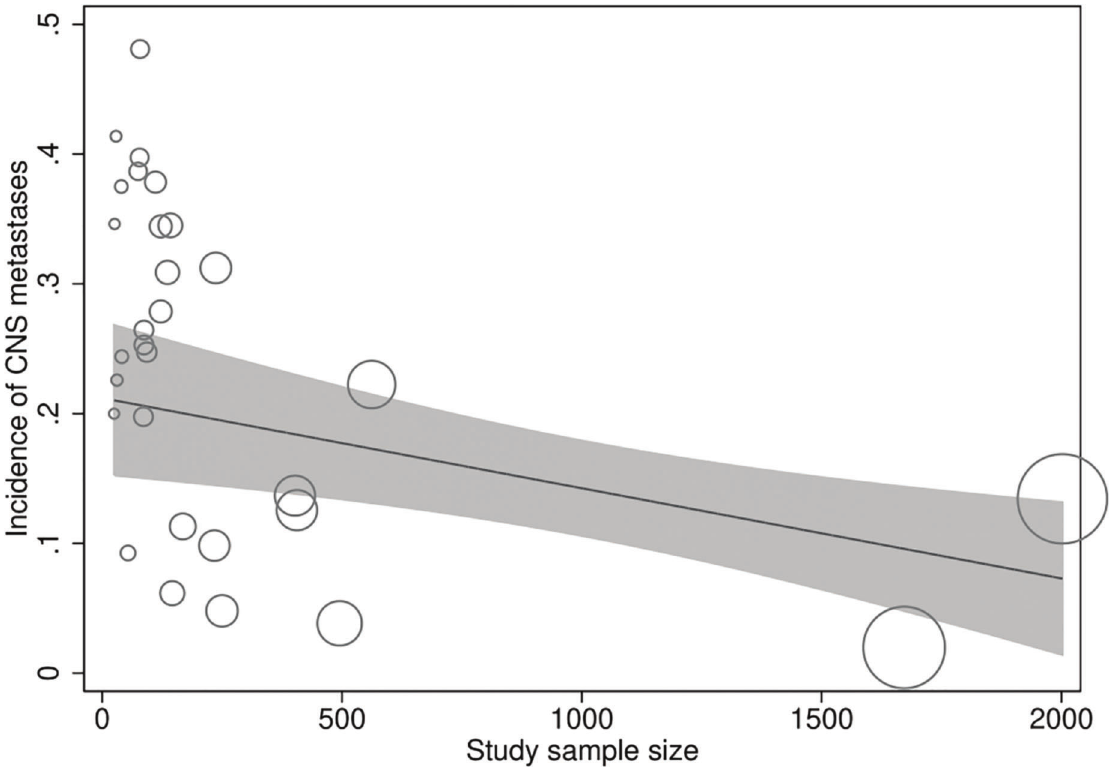
Figure 4 - Meta-regression scatterplot showing the relationship of the incidence rate of CNS metastases in patients with HER2-positive MBC treated with trastuzumab to the study sample